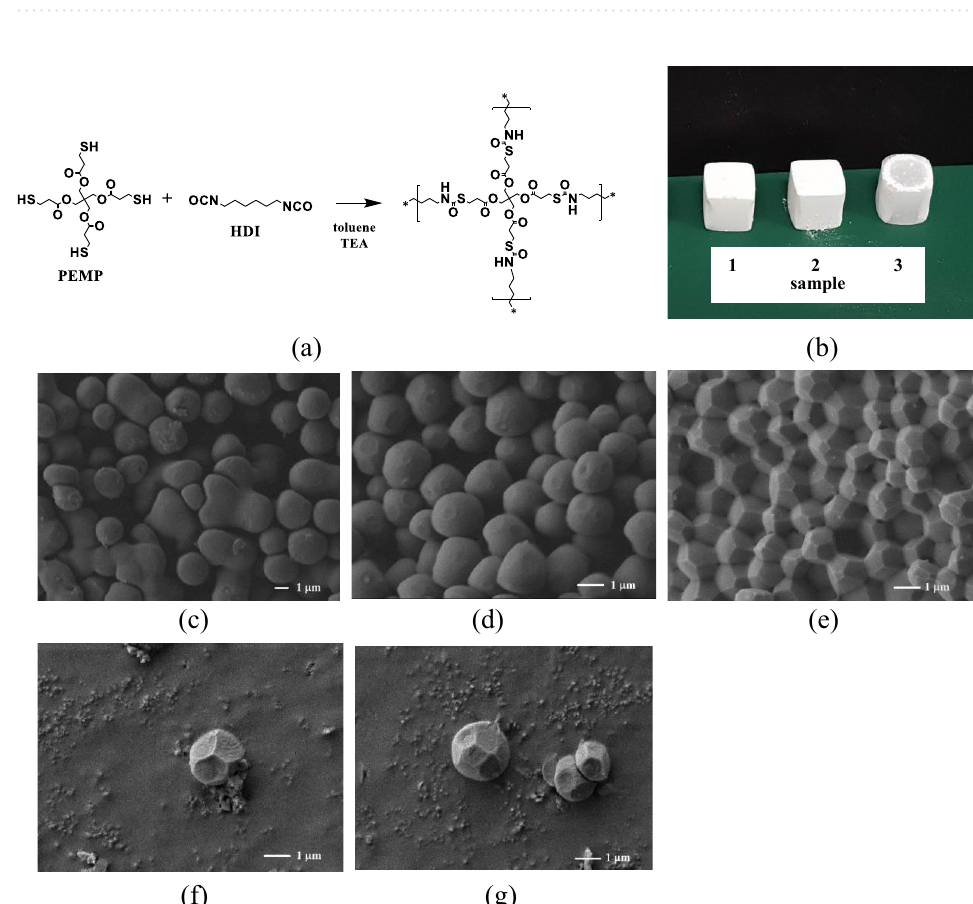
Figure 2. ( a ) Synthetic scheme of network polymers through the addition reaction of PEMP and HDI in toluene, and photos and images of the polymers, ( b ) Photos of PEMP-HDI network polymers from the reaction systems at monomer concentrations in the reaction systems of sample 1 (left): 25 wt%, sample 2 (center): 30 wt%, and sample 3 (right): 35 wt%, SEM images of PEMP-HDI network polymers ( c ) 25 wt% (sample 1), ( d ) 30 wt% (sample 2), and ( e )–( g ) 35 wt% (sample